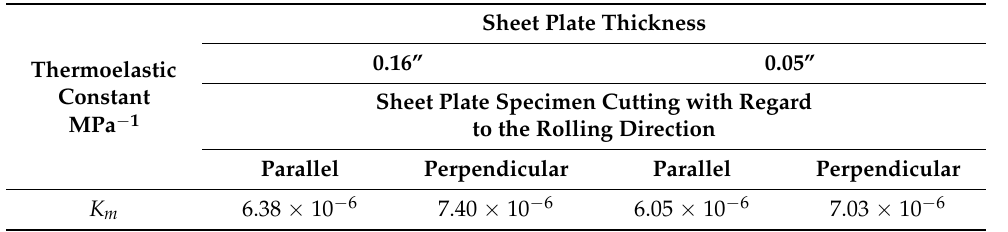
Table 10. A summary of the thermoelastic material constant K m for sheet plates made of the 2024-T3 aluminum alloy depending on the thickness and the rolling